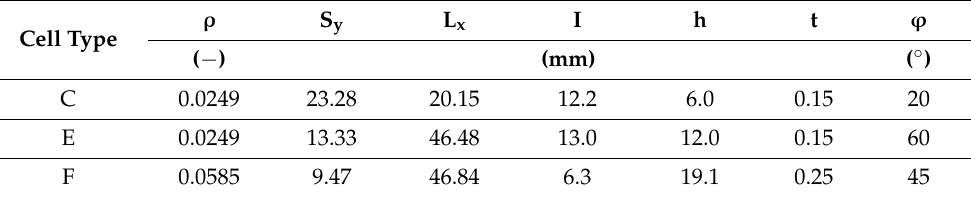
Table 1. Characteristics of cells used for tests, where: ρ —relative cell density, S y —cell width, L x —cell length, l—length of the free cell wall, h—length of the double cell wall, t—thickness of the cell wall (paper), ϕ –cell wall inclination angle (Figure 1).